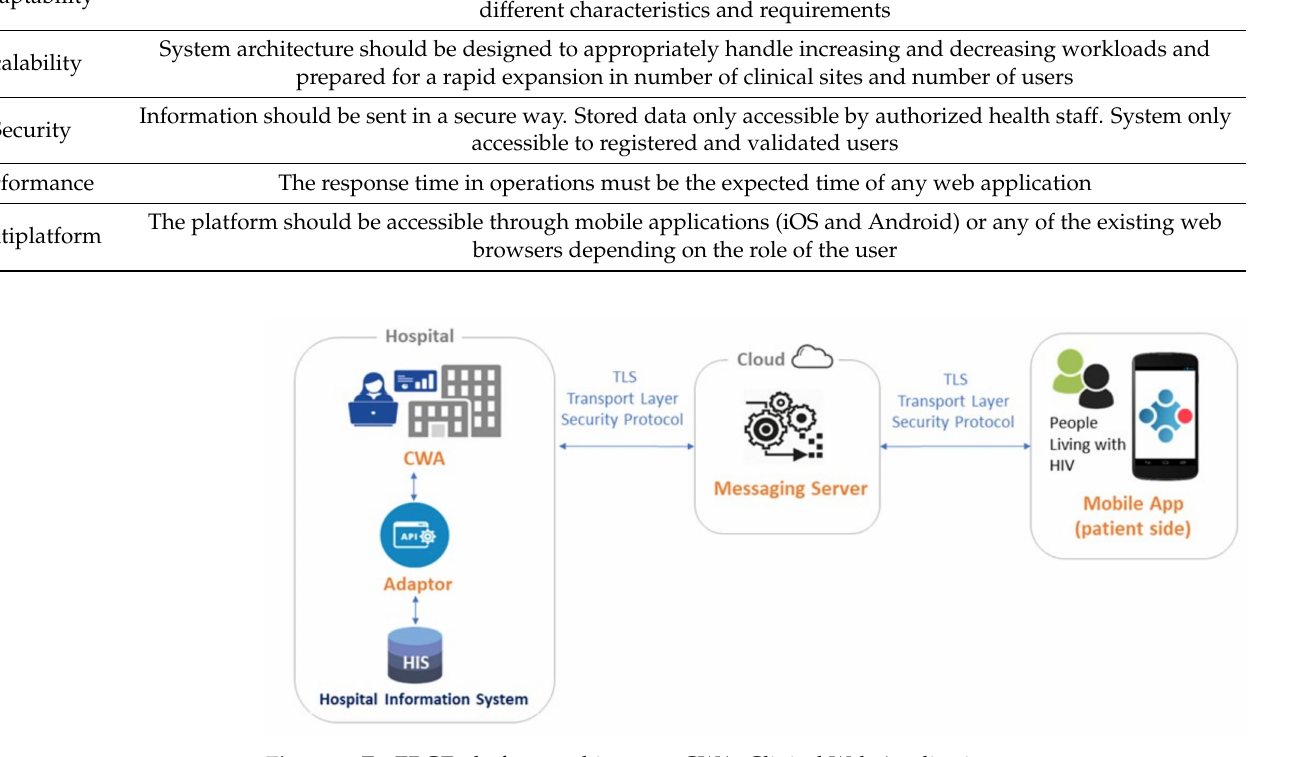
Figure 1. EmERGE platform architecture. CWA: Clinical Web